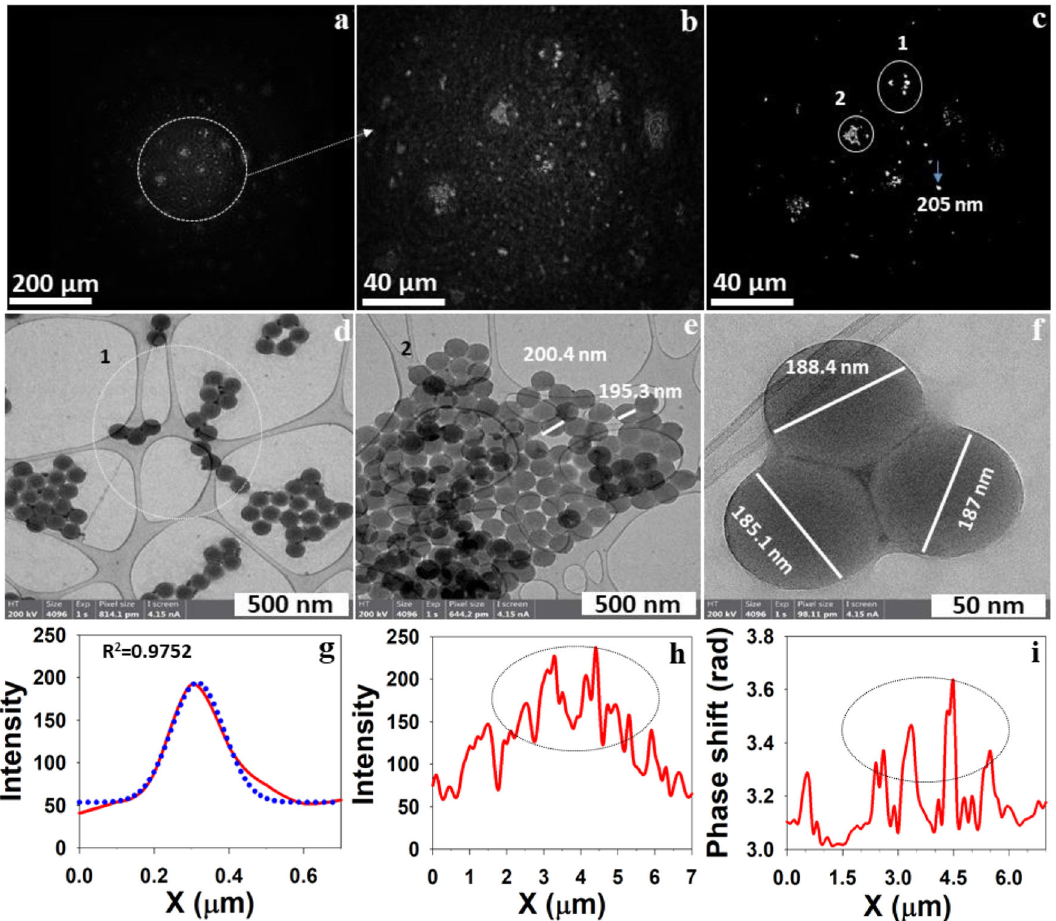
Fig. 6 Holographic reconstruction of 200 nm PSL particles deposited on a microscope slide and their validation by S/TEM images. a Intensity reconstruction at 2318 µ m. b Zoomed-in area of a . c In-focus, high-resolution reconstruction at Z = 2321 µ m. d – f S/TEM images of same 200 nm PSL samples. Circle 1 and 2 in image c show the good agreement with S/TEM images shown in d , e . g Intensity crosscut of particles in c with a diameter of 205 nm. h , i Intensity and phase crosscut of particles with the con fi rmation of existing clusters of PSL particles. Similar con fi rmation by S/TEM image in e suggested the presence of a cluster of PSL particles. Phase reconstruction of 200 nm PSL particles shown in Supplementary Fig.